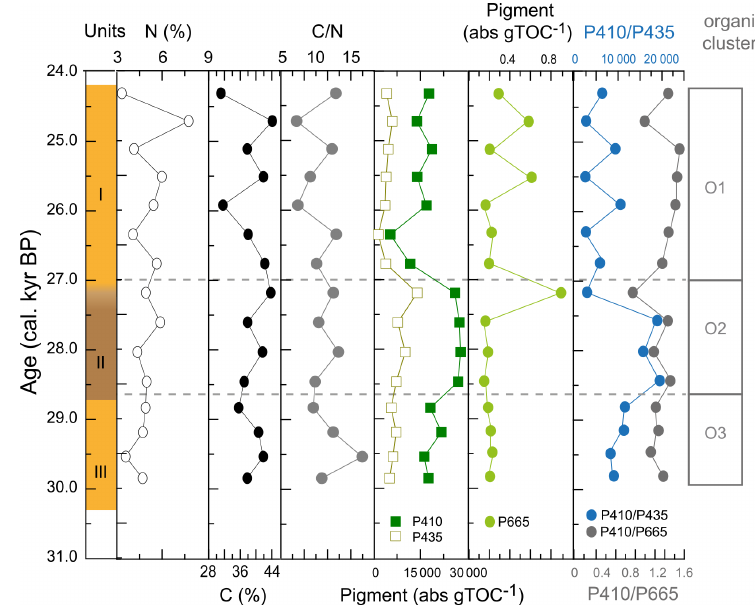
Figure A5. Additional indicators of organic matter composition of WMM7. The %N and %TOC were used to generate the C / N ratios presented in Fig. 4. The dominant pigments (P410, P435) are shown in comparison to the much lower contribution of P665, which has an exclusive chlorin origin but which is also 3 orders of magnitude lower in abundance than